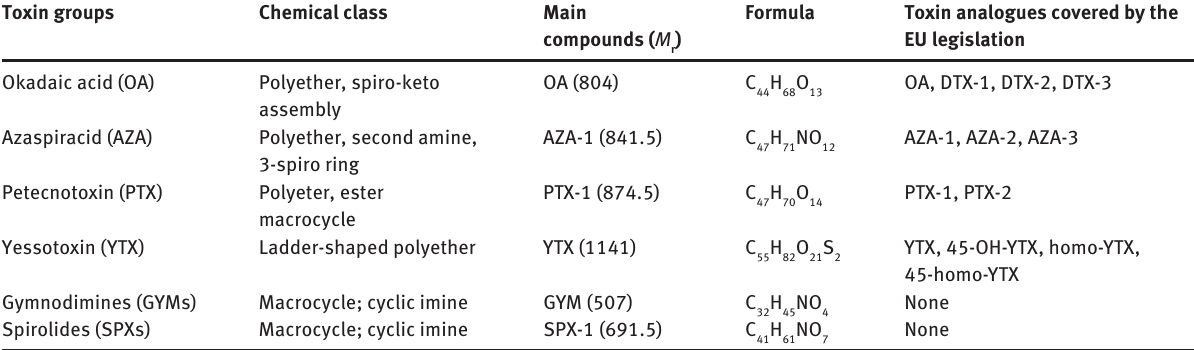
Table 3 Chemical characteristics of lipophilic marine toxins. EU, European